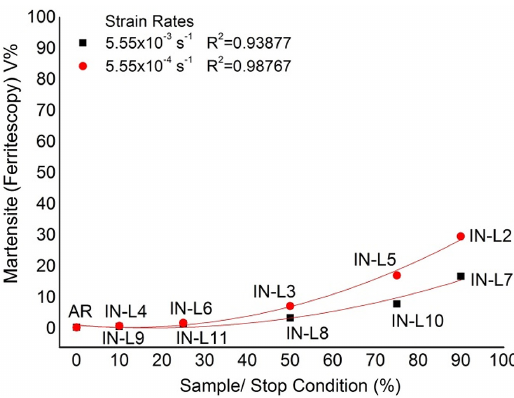
Figure 2. Volume fraction of deformation induced martensite in samples of the first group for two different strain rates, measured by ferritoscopy. Samples with